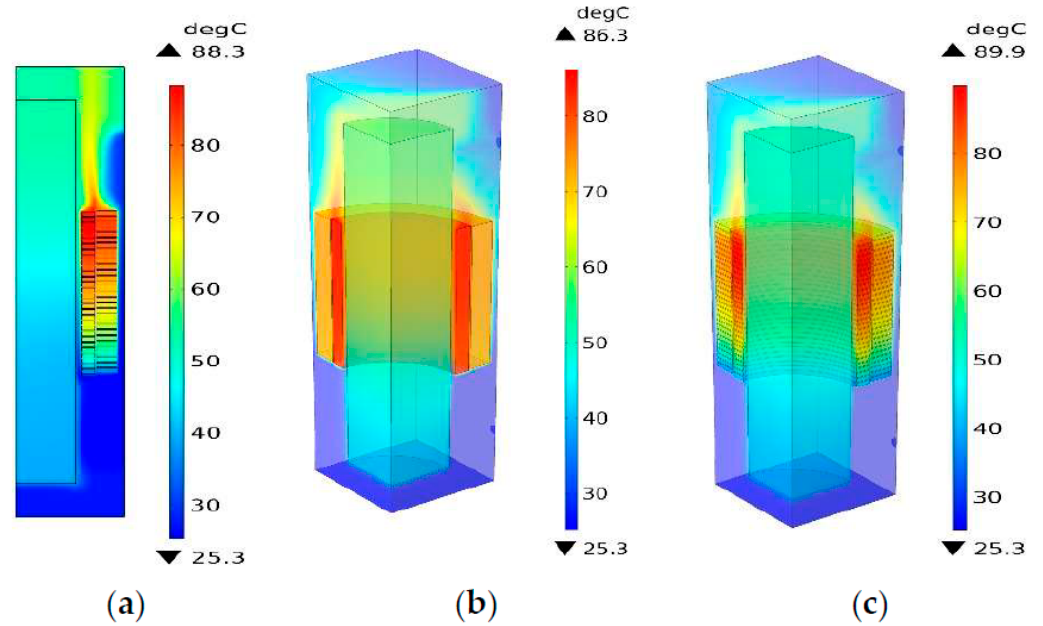
Figure 4. Temperature field distribution of the transformer. ( a ) Two-dimensional temperature field distribution diagram; ( b ) three-dimensional temperature field distribution diagram; ( c ) improved three-dimensional temperature field distribution diagram.